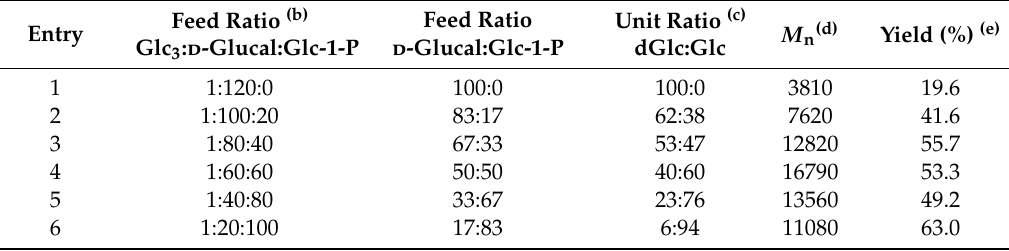
Table 1. Thermostable α -glucan phosphorylase-catalyzed enzymatic copolymerization of d -glucal with Glc-1-P (a) .